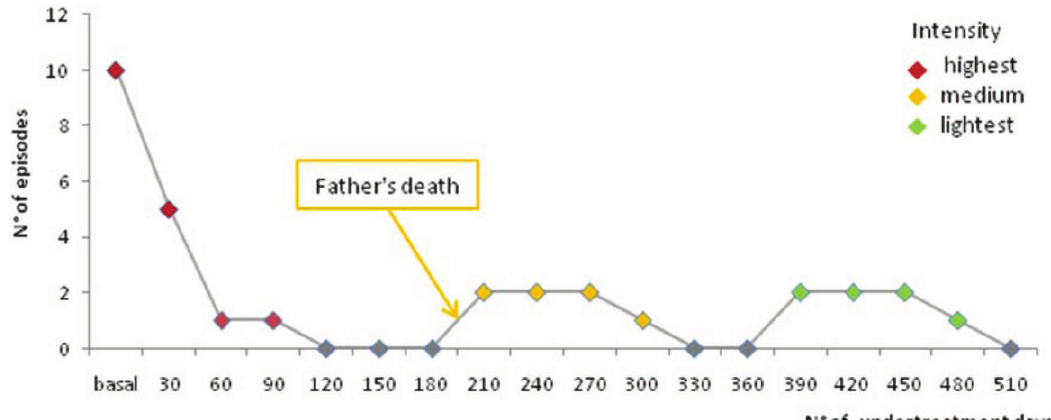
Figure 1 - Frequency of sleepwalking episodes during the treatment period (Case